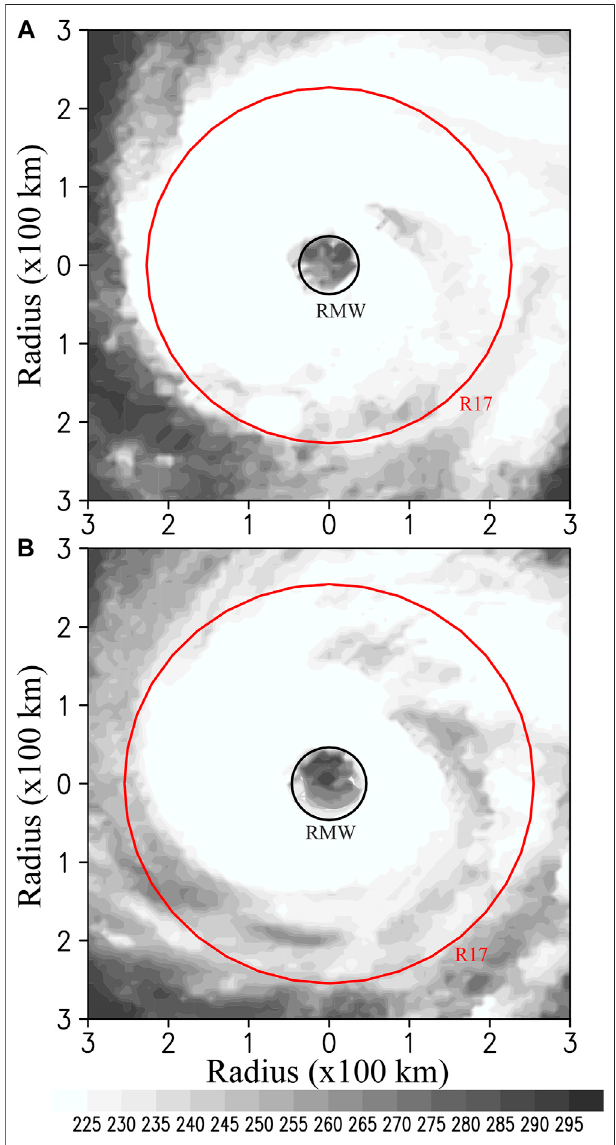
FIGURE2| Horizontaldistributionoftheinfraredbrightnesstemperature (shaded, K) from NOAA FCDR at (A) 1800 UTC Sep 17, 2006 and (B) 0000 UTCSep18,2006.TheblackandredcirclesindicatetheRMWandtheradius of the 34-kt wind (R17).